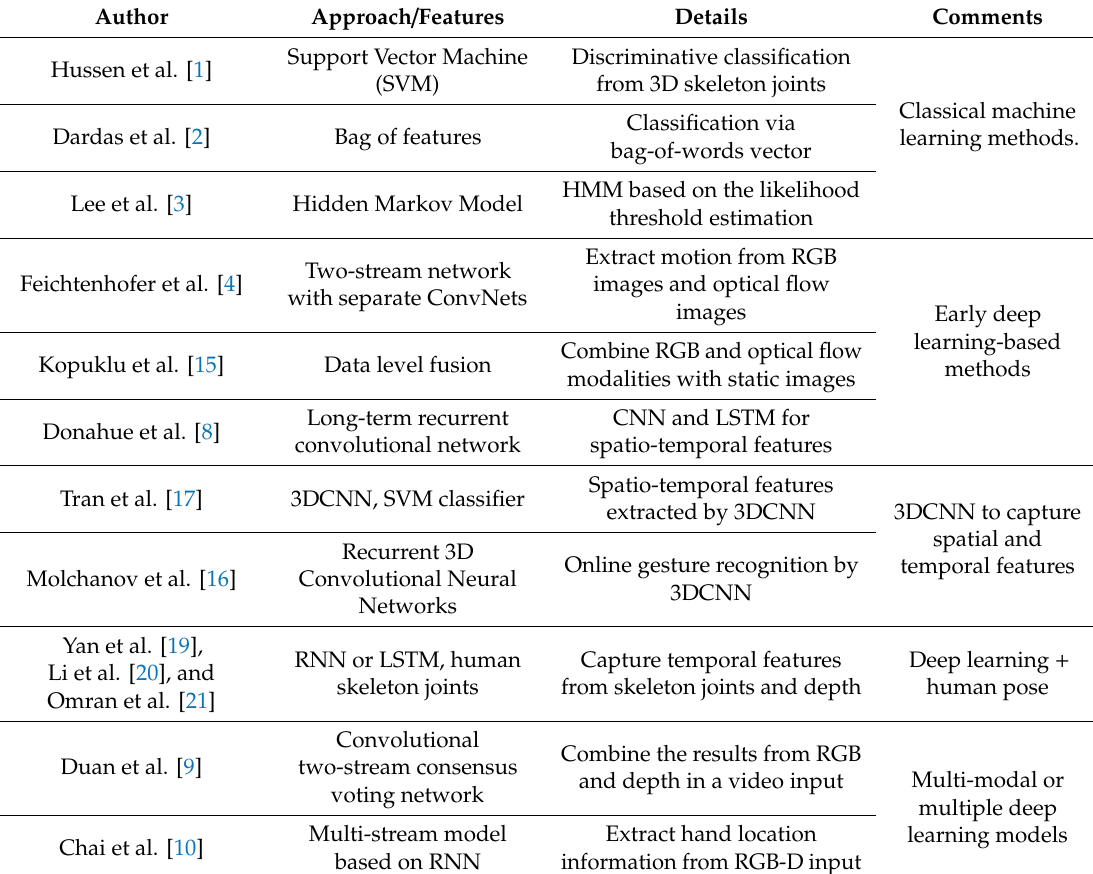
Table 1. The summary of related